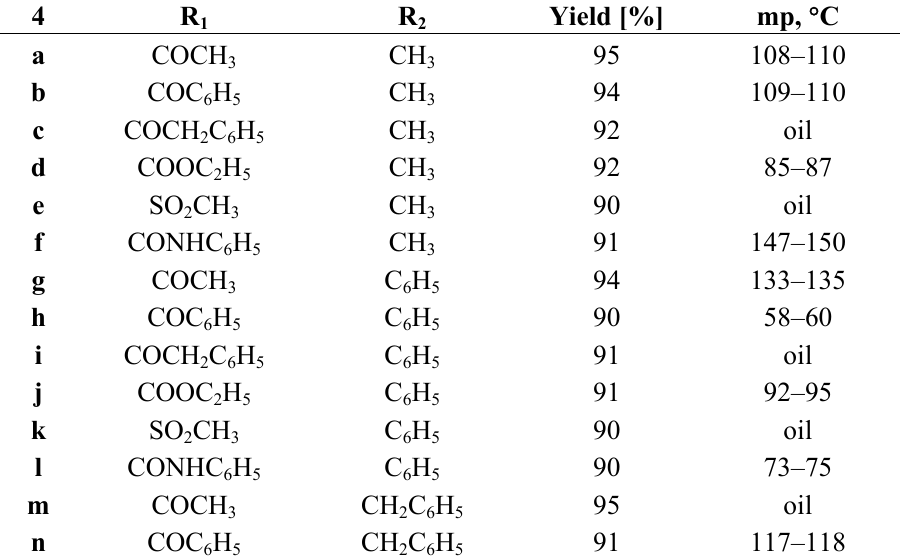
Table 2. Synthesis of hydroxyamides 4 .